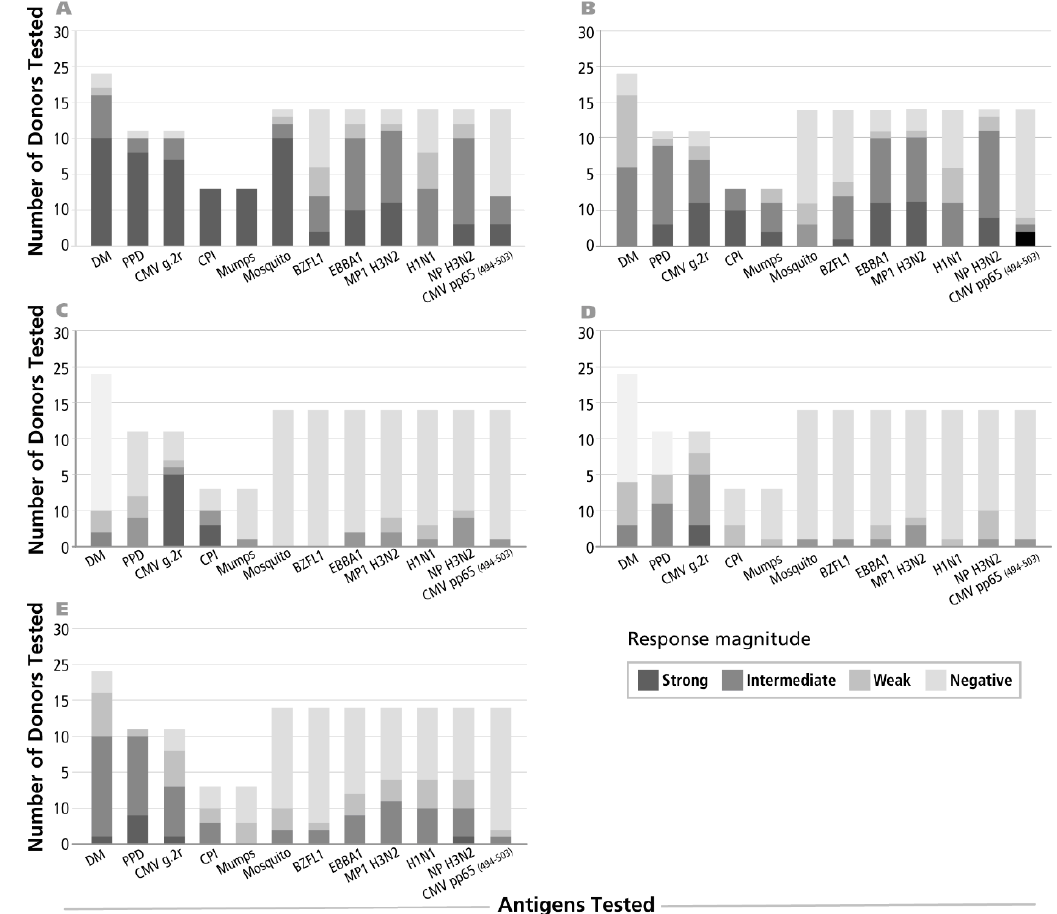
Figure 1. Gradation of magnitudes for antigen-specific recall responses. Peripheral blood mononuclear cells (PBMC) of healthy human donors were tested for recall responses to the antigens specified on the X axis—the numbers of PBMC donors tested is specified on the Y axis. In panel ( A ) the results for IFN- γ are shown; in ( B – E ) for IL-2, IL-4, IL-5 and IL-17, respectively. Response magnitudes are indicated by different shades, as specified, and are defined as follows: negative, off-white: no statistically significant difference between three medium control wells and the three antigen wells tested, as defined by the Student’s t -test, and a cut-off value of p > 0.05. Weak response, in light grey: spot counts reaching statistical difference, but less than 20 SFU per 400/000 PBMC. Intermediate response, in dark grey: Spot Forming Unit (SFU) counts for antigen-induced response between 20 and 100. Strong response, in black: more than 100 antigen-induced SFU/400,000 cells.